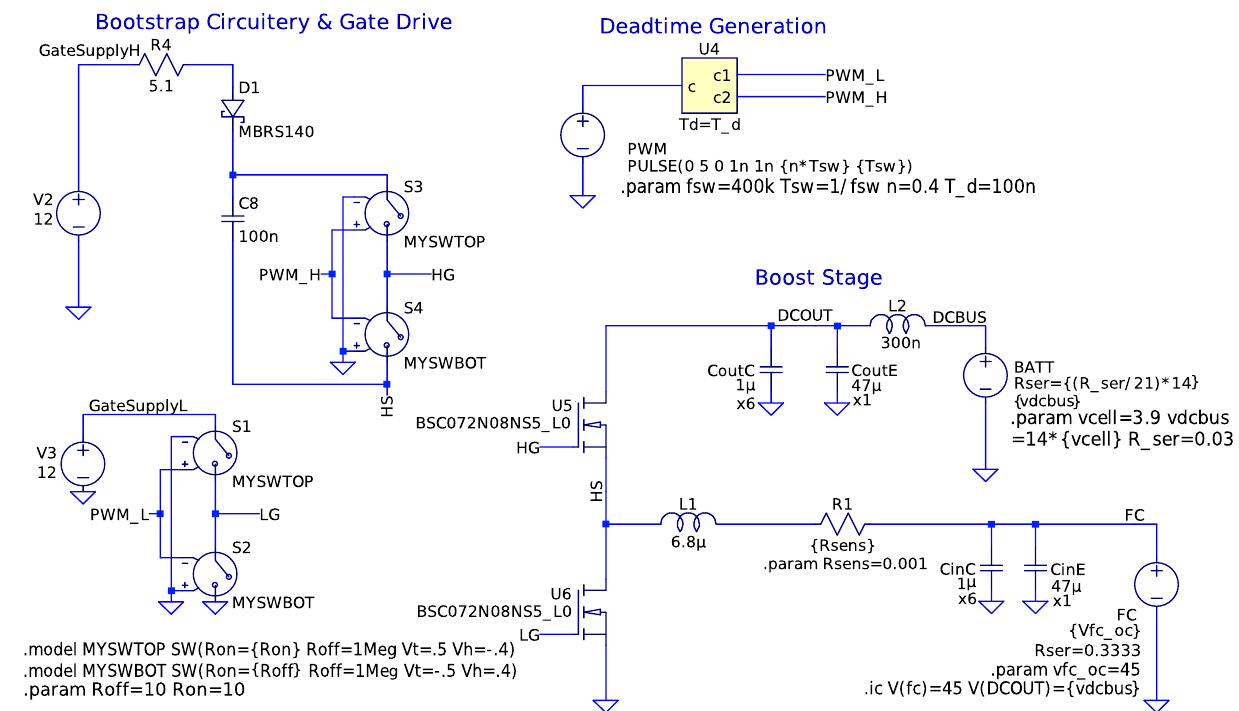
Figure 11. LTspice model of one phase of the boost converter.